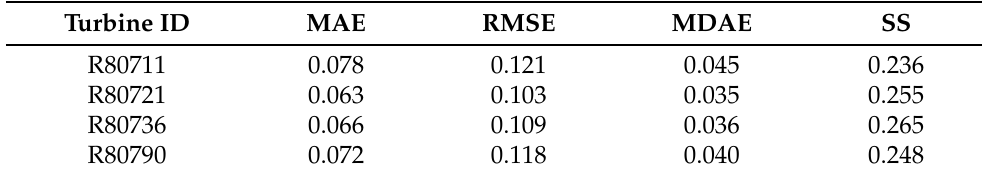
Table 1. The table presents the prediction errors in terms of MAE, RMSE, and MDAE averaged over lead times, together with the overall SS, for all four wind